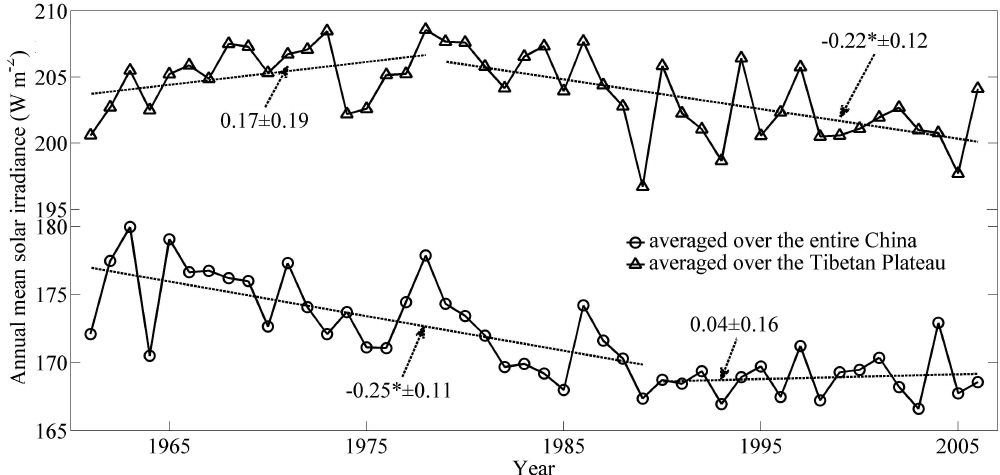
Fig. 6. The hybrid model-derived time series of the annual mean solar irradiance averaged over the entire China and averaged over the Tibetan Plateau during 1961 ∼ 2006. The star symbol (*) denotes a trend that passes the significance test ( p < 0 . 05). The unit of the trend is Wm − 2 yr − 1 .